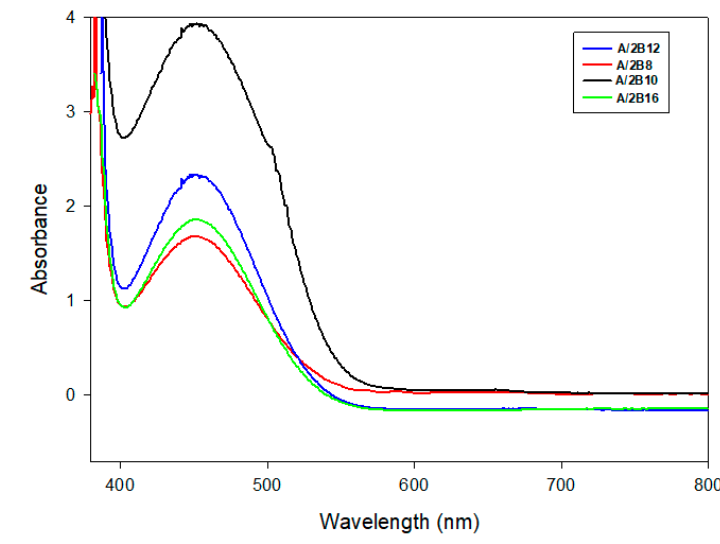
Figure 7. UV-absorption spectrum of present HBSMCs, A/2Bn, in chloroform.